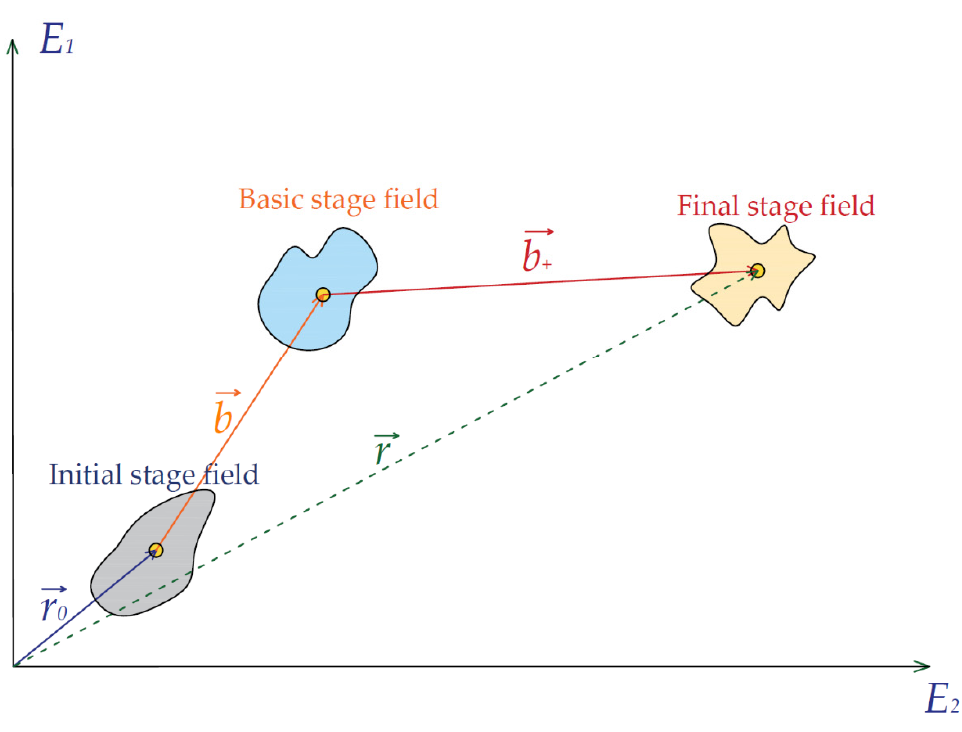
Figure 2. Energy state fields of stability analysis.